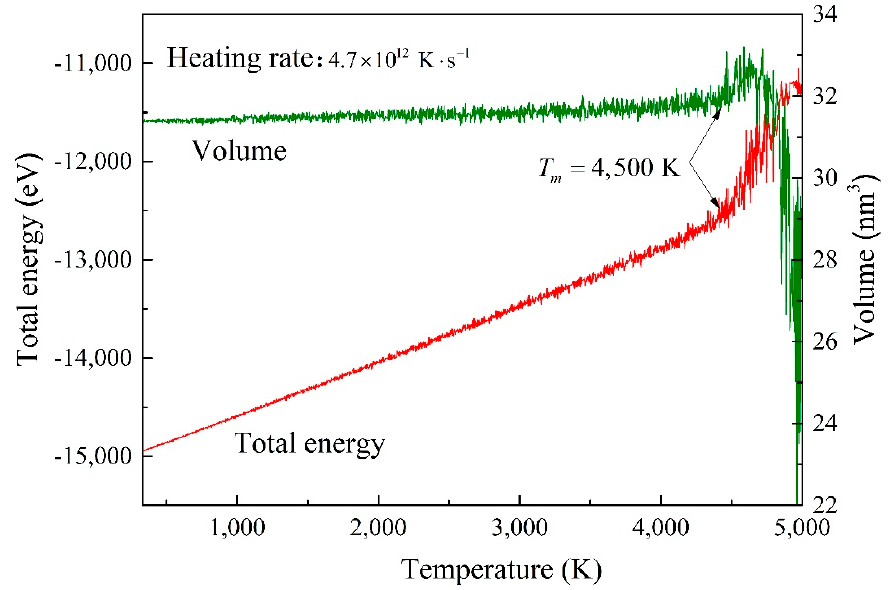
Figure 2. The curves of total energy and volume versus temperature during heating of boron nitride honeycombs (BNHCs).